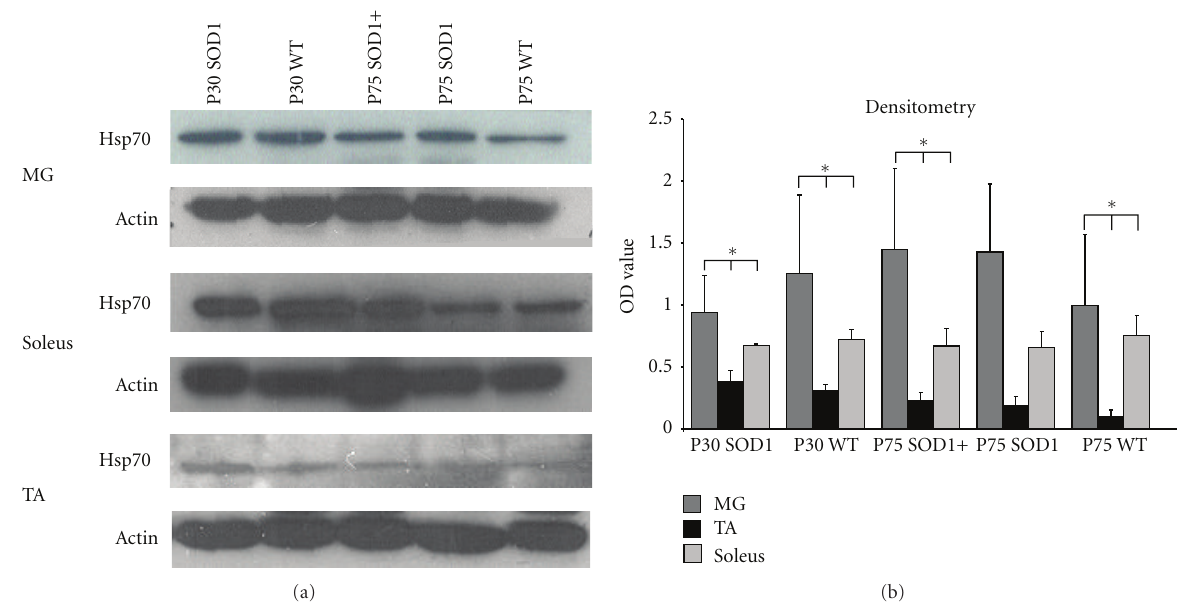
Figure 7: Muscles with type 1 fibers have increased expression of Hsp70 as compared to muscles with predominantly Type 2 fibers. (a) Images of representative Western blots probed for Hsp70 or actin (loading control). (b) Quantification of Hsp70 expression was performed with densitometry analysis confirmed increased expression of Hsp70 in muscles containing type 1 fibers. There was no significant di ff erence in Hsp70 expression between WT and SOD1 muscles and treatment with rhHsp70 did not a ff ect this expression. Statistical significance was determined using a two-way ANOVA followed by Tukey-Kramer post hoc test ( n = 3 ∗ P < 0 .